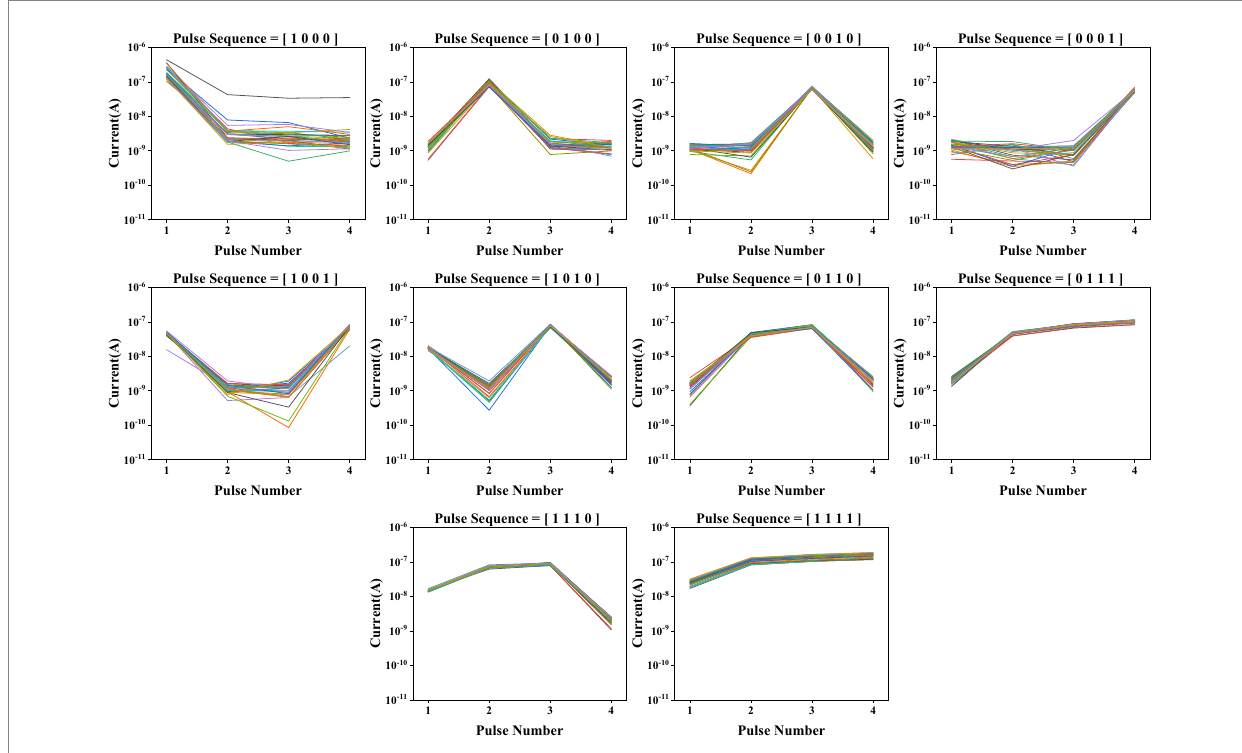
FIGURE 4 Evolutions of the currents passing through the memristor upon receiving trains of pulses with different patterns. Measurements are conducted for 30 times.